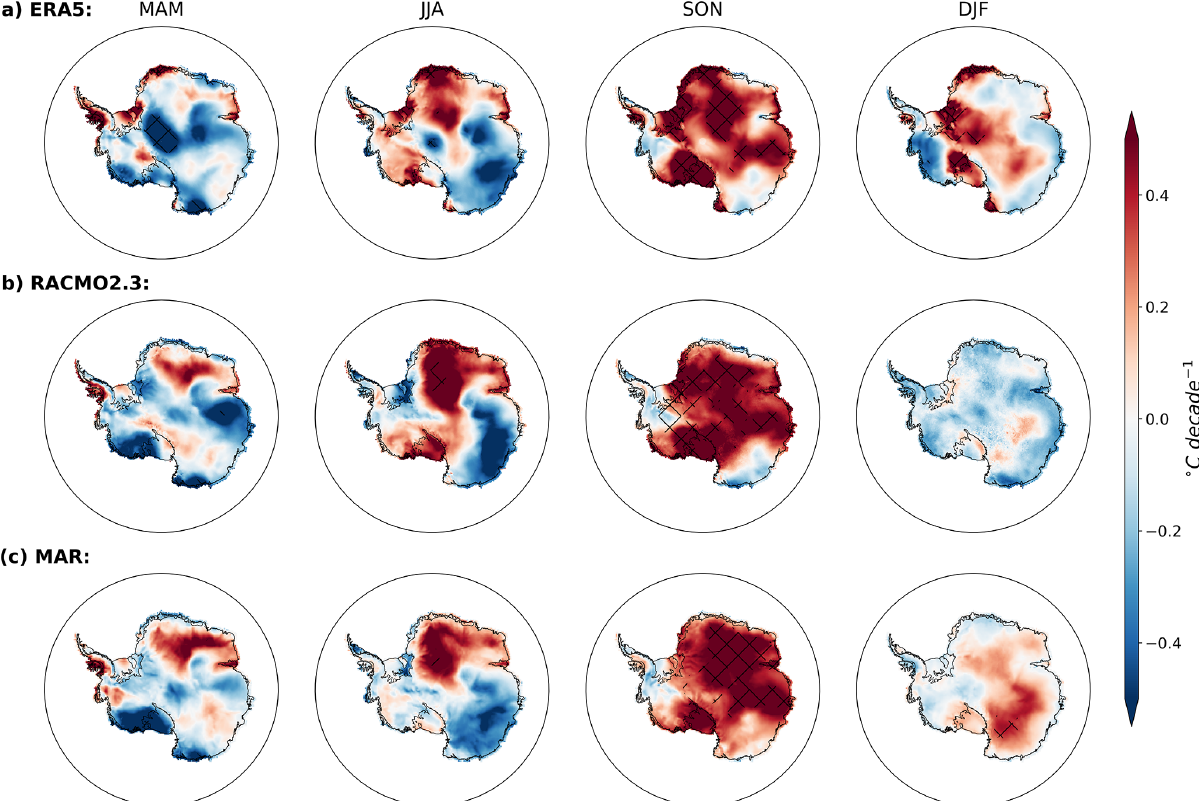
Figure A1. 1979–2015 seasonal trend in near-surface temperature from ERA5 (a) , RACMO2.3 (b) , and MAR (c) . Cross-hatched areas represent regions where this trend is significant ( p <